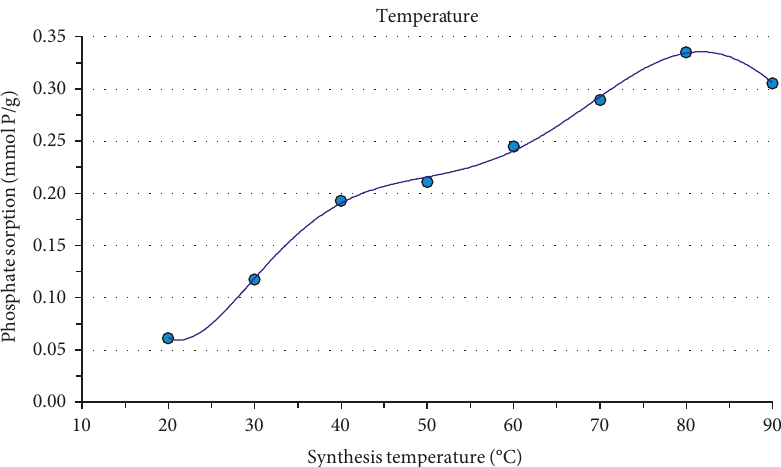
Figure 6: Phosphate sorption (expressed as P) by CALV biosorbent in the function of the synthesis temperature (20–90 ° C). Table 2: Elemental analysis and reaction efficiency of synthesized CALV and CARLVS biosorbents compared to the raw LVS biomass and MLV precursor. Sample